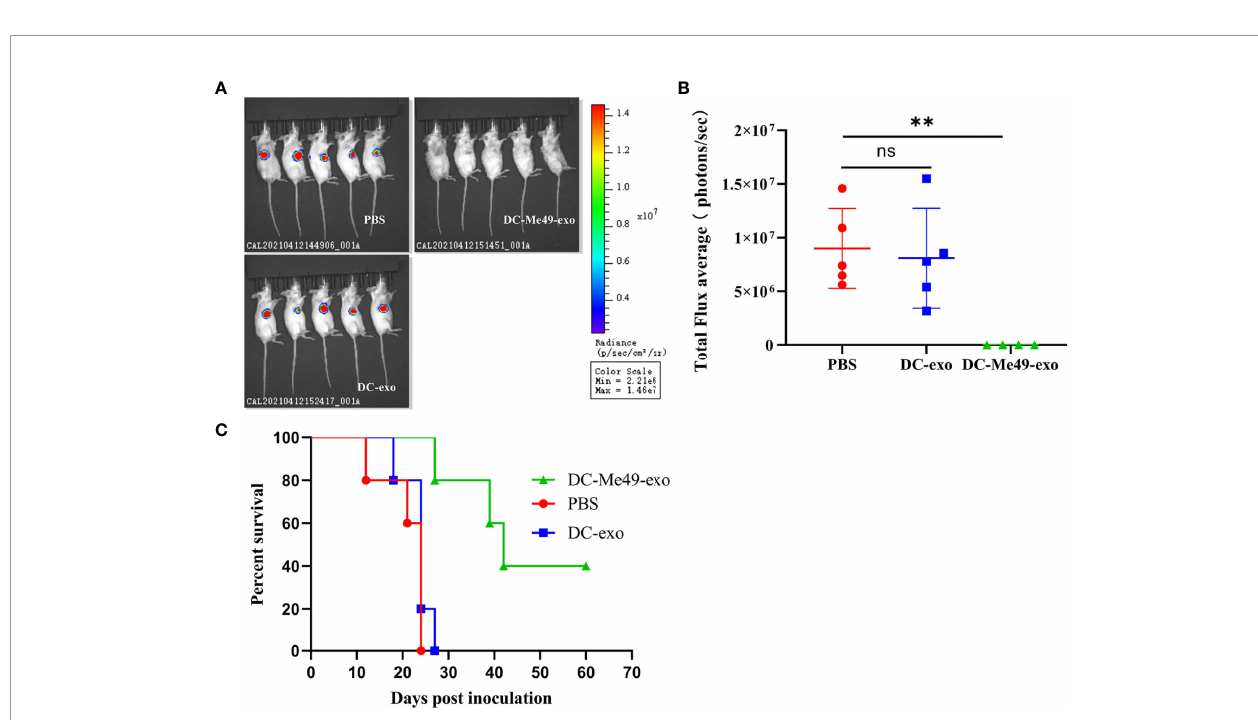
FIGURE 3 | DC-Me49-exo inhibited tumor growth in a mouse model of CRC. CT26 cells were injected subcutaneously, and DC-exo, DC-Me49-exo and PBS from different groups were injected into the tumor. (A) Fluorescence intensity in tumor-bearing mice after exosome treatment detected using an IVIS imaging system. (B) In vivo fl uorescence imaging of tumor-bearing mice treated with exosomes. PBS, DC-exo and DC-Me49-exo represent control group, DC-exo treatment group and DC-Me49-exo treatment group, respectively. (C) Survival curve of a mouse model with CRC after exosome treatment (n=10). ns, ( p ≥ 0.05), ** p <